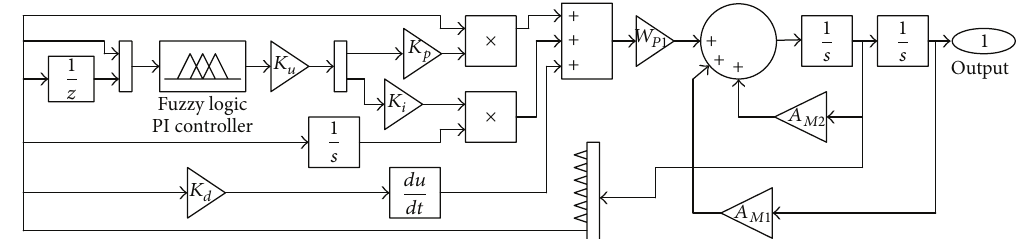
Figure 6: The block diagram of FPI PID strategy.